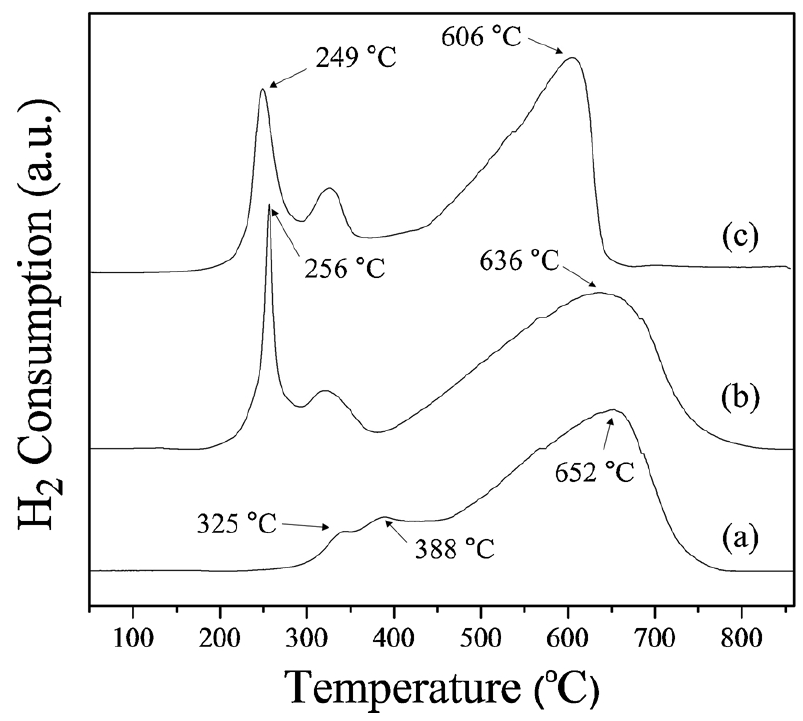
Figure 1. H 2 -TPR Comparison: (a) raw iron ore, (b) promoted iron ore, (c) precipitated iron catalyst [6]. Reproduced with permission from Elsevier.